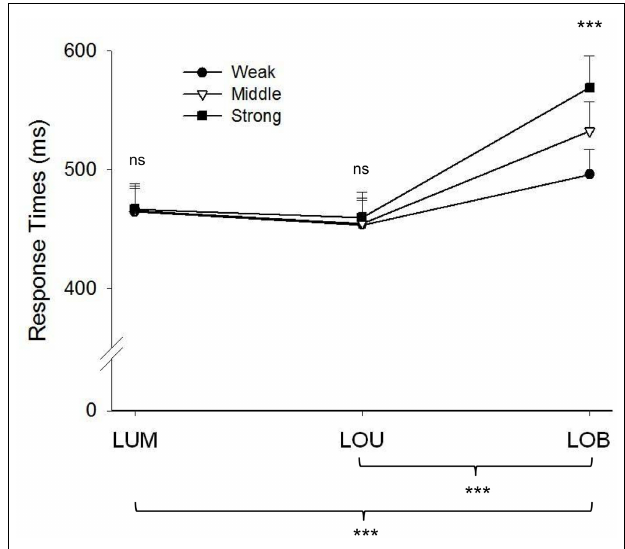
FIGURE 3 | Mean response times (RT) with error bars depicting the standard error. Compared to the remaining change conditions higher RTs were observed in the LOB condition.While no salience effect was observed for the LUM and LOU change condition RTs in the LOB condition increased with heightening salience of the motion transient. Significant differences between change conditions (below the figure) and significant salient effects are marked. * p < 0.05, ** p < 0.01, *** p < 0.001 (ns =